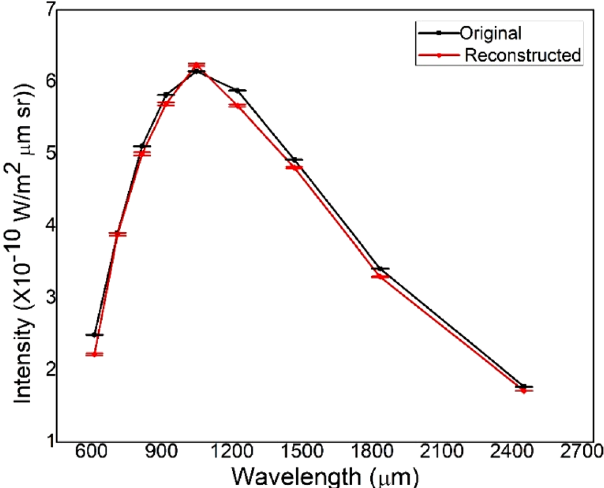
Figure 4. The obtained probability distribution of temperature is used to reconstruct the intensity of the original input data. Both of the intensities are plotted together against wavelength. The error bars are also shown.